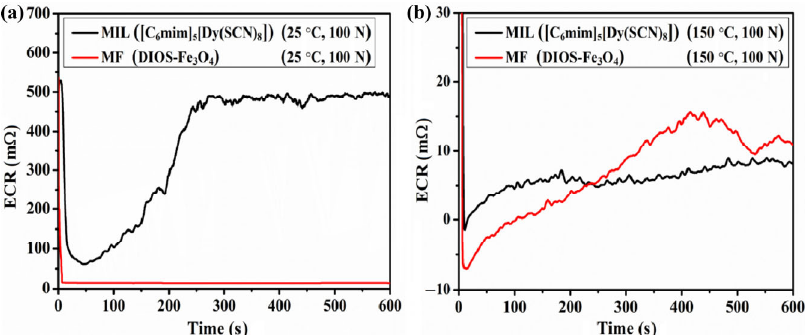
Fig. 15 Variation in the electric contact resistance of the sliding pair lubricated by MIL and MF versus time at (a) 25 and (b) 150 ° C.